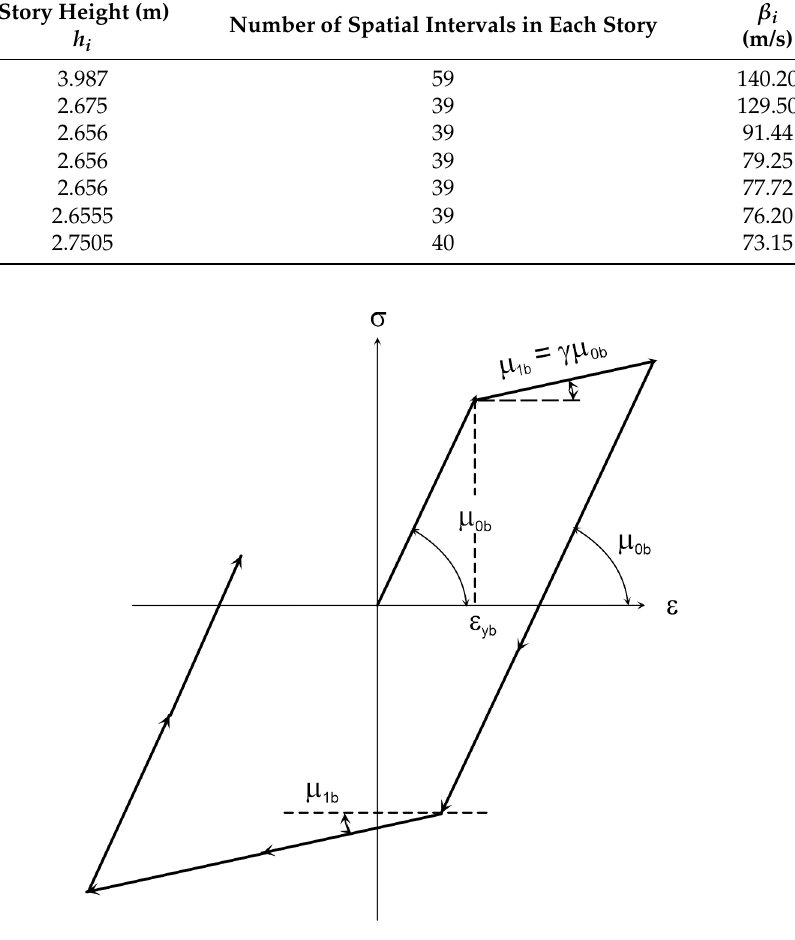
Figure 7. The constitutive law for the shear-building material.